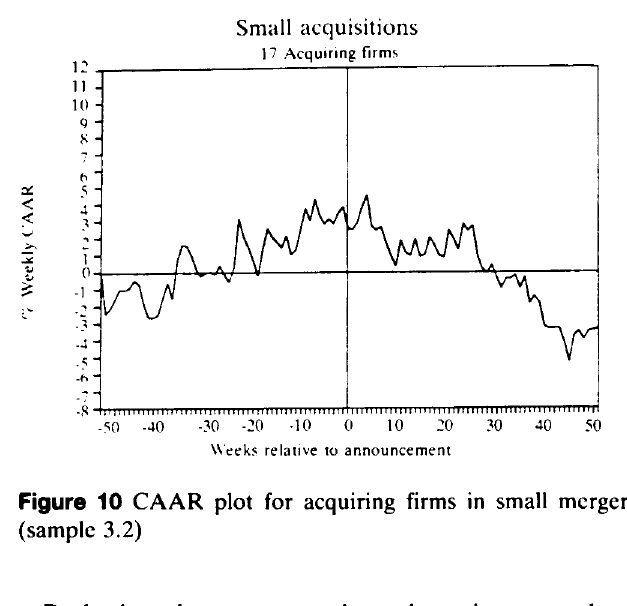
Figure 10 CAAR plot for acquiring firms in small mergers (sample 3.2)